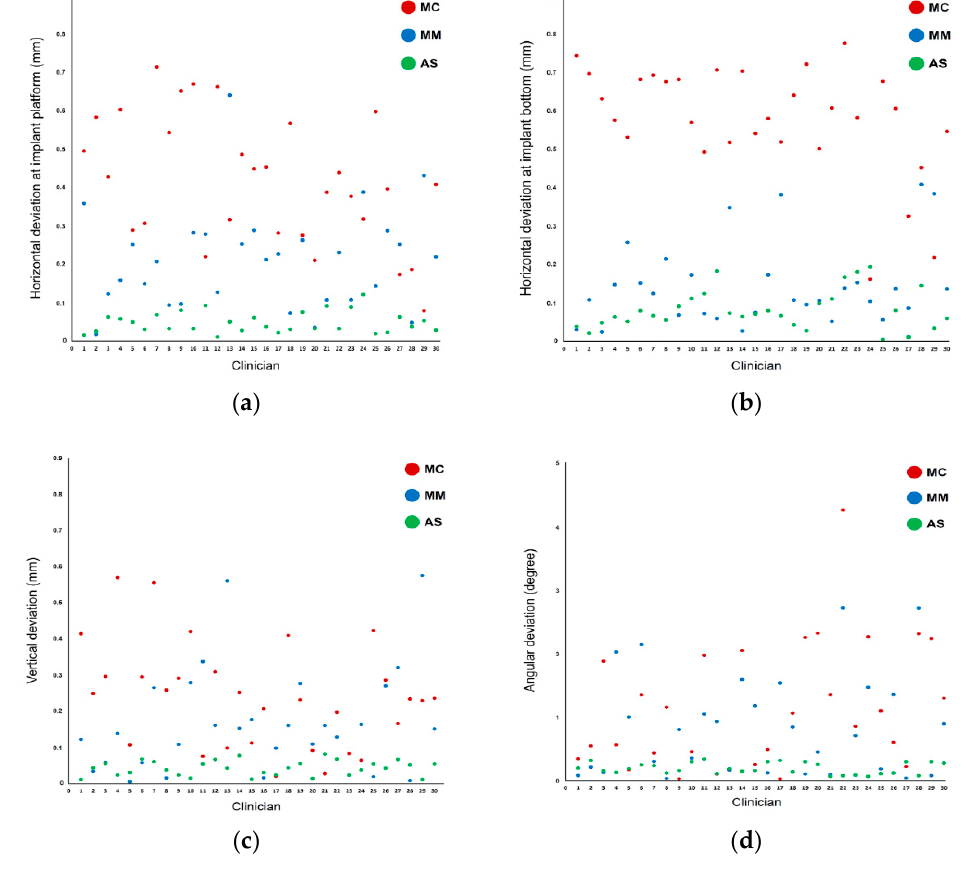
Figure 6. Scatterplot of deviations among the different methods used for implant detection: ( a ) linear deviations at the platform; ( b ) linear deviations at the bottom; ( c ) vertical deviations; ( d ) angular deviations.